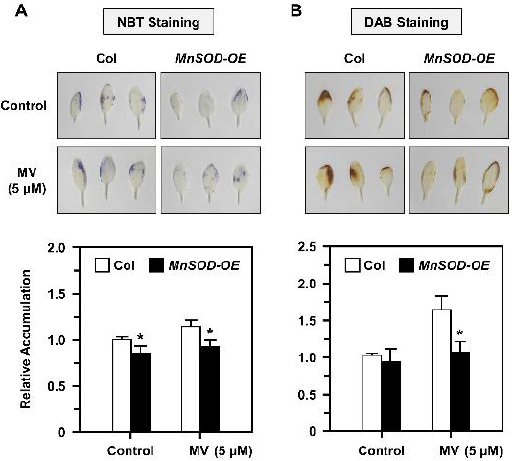
Figure 5. O 2 •− and H 2 O 2 accumulation of Col and MnSOD-OE seedlings under MV stress. ( A , B ) Twenty-one-day-old seedlings were treated with 5 µ M MV for 3 days, then O 2 •− and H 2 O 2 accumulation were analyzed by NBT and DAB staining ( top ), respectively. Each accumulation in a plant was measured relative to Col ( bottom ). Data are mean ± SD of three independent repeats. * Significant at p < 0.05 compared with the